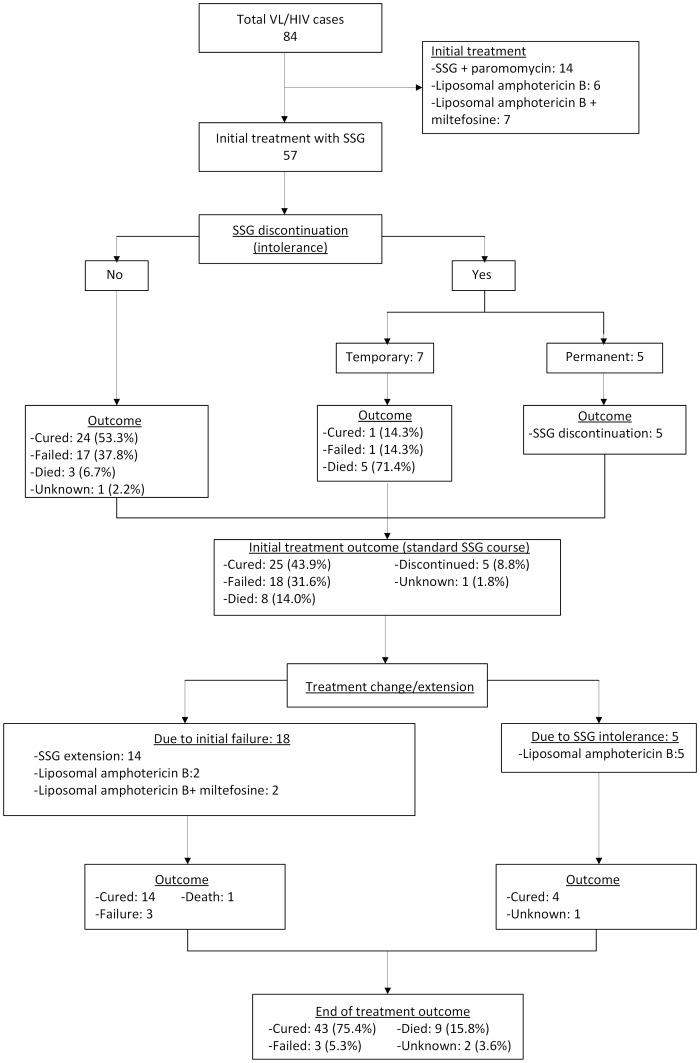
Flow diagram showing the number of patients in the study and their outcomes.